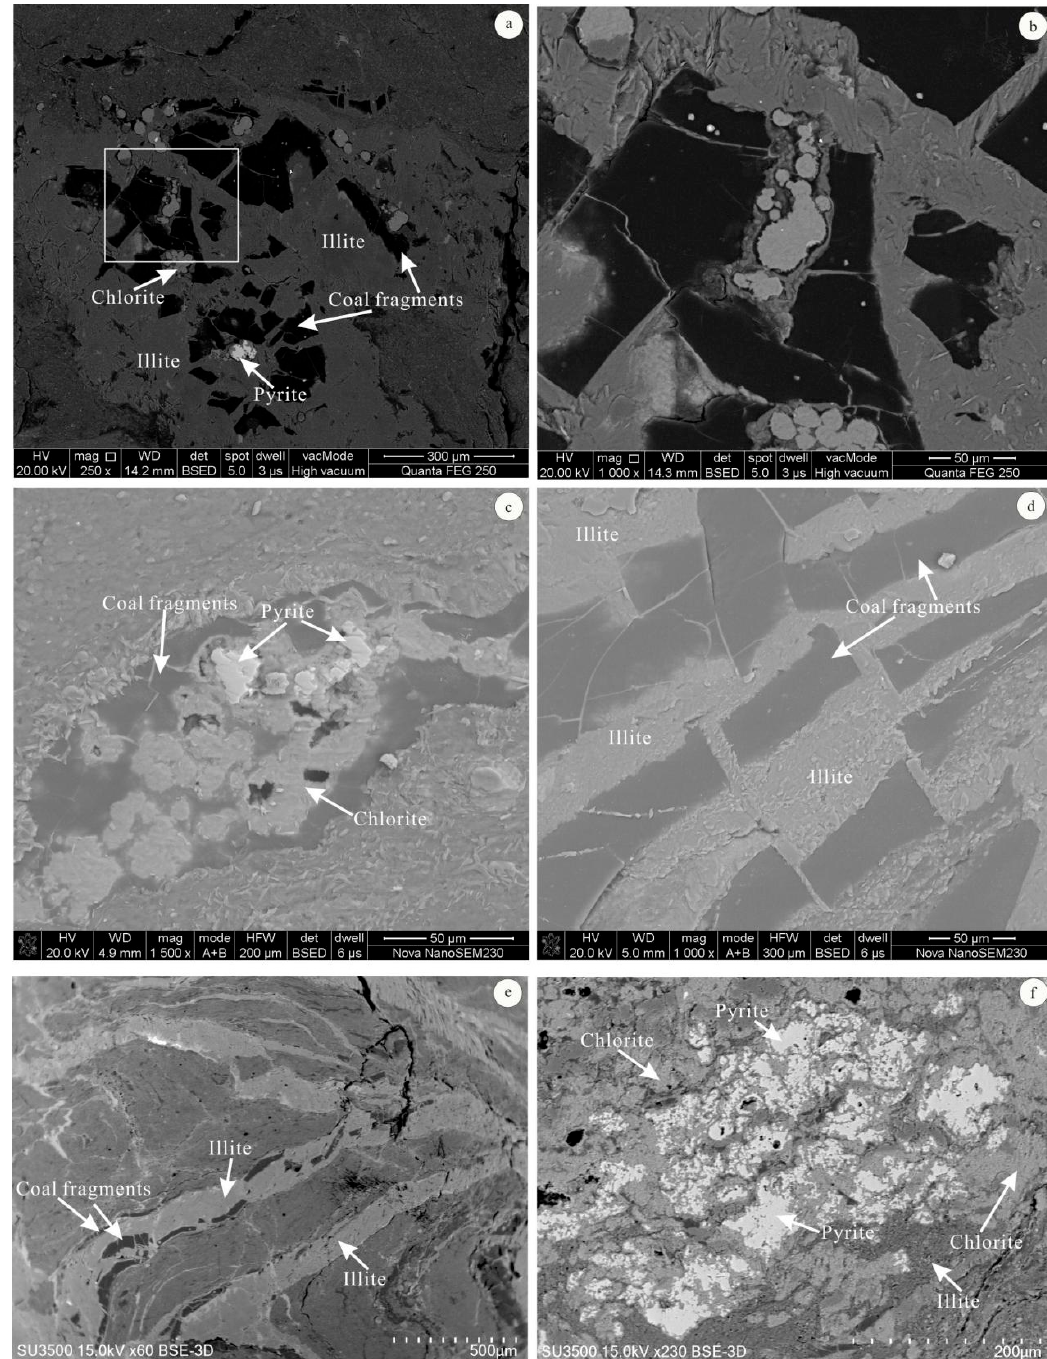
Figure 9. SEM and back-scattered electron images of minerals in partings. ( a ) Fracture-filling illite and some chlorite, pyrite, and coal fragments distributed in the illite in sample 12U-P; ( b ) enlargement of the white square in ( a ); ( c ) fracture-filling chlorite and coal fragments in sample 12U-P; ( d ) fracture-filling illite and coal fragments in sample 12L-P; ( e ) fracture-filling illite and coal fragments in sample 12L-P; ( f ) fracture-filling illite, chlorite, and pyrite in sample 12L-P.